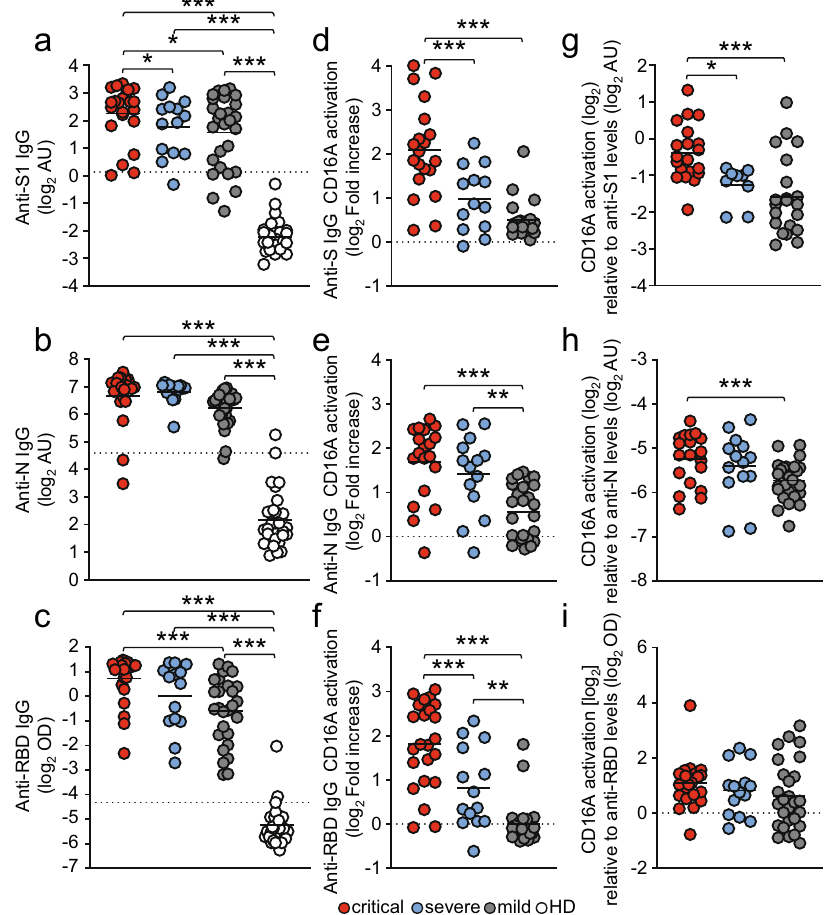
Fig. 2 | Fc γ RIIIA/CD16A activation by SARS-CoV-2 - speci fi c IgG is enhanced in criticallydiseasedpatients. Fc γ RIIIA/CD16AactivationofBW5147reportercellsby SARS-CoV-2-speci fi c IgG in serum samples obtained 13-25days following symptom onset from 23 critically (red symbols) and 14 severely (blue symbols) diseased patients. Between 2 to 8 samples/patient were analyzed depending on the avail- ability of sample material. Sera from 28 non-hospitalized patients with mild SARS- CoV-2 infection (grey symbols) and 30 healthy donors (open circles) served as reference. Each symbol represents the mean value of all available samples per